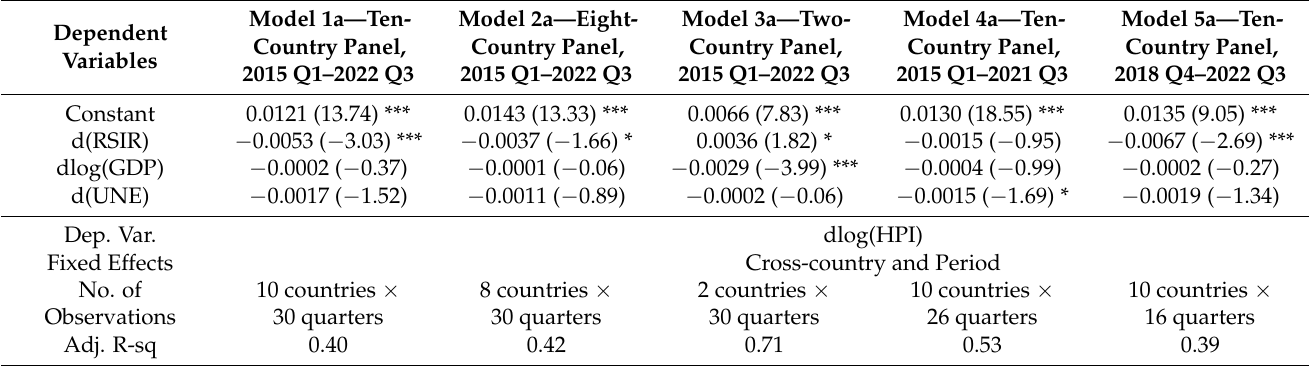
Table 4. Results of the ten-country panel regression models on house price change and real short-term interest rates, with both cross-country and period fixed effects.